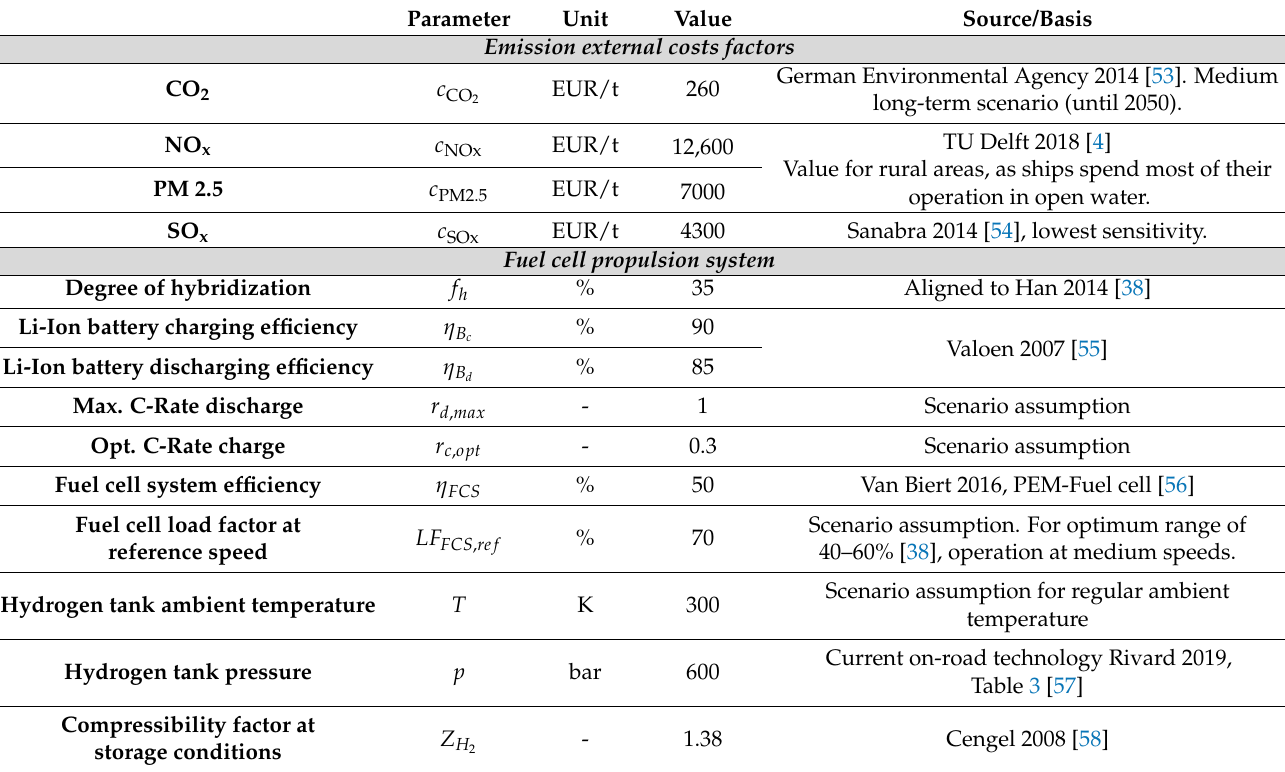
Table A3. Specific parameter set for the case study, presented in this paper, with sources or explana- tions for the values